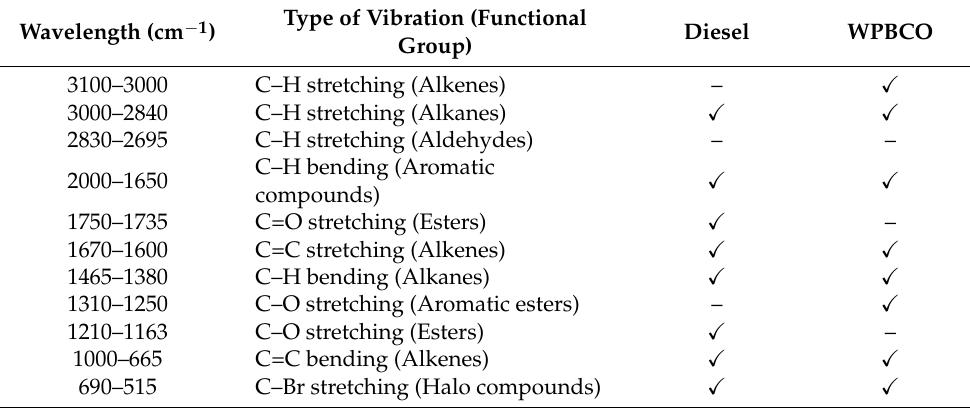
Table 5. The functional group composition present in diesel fuel and